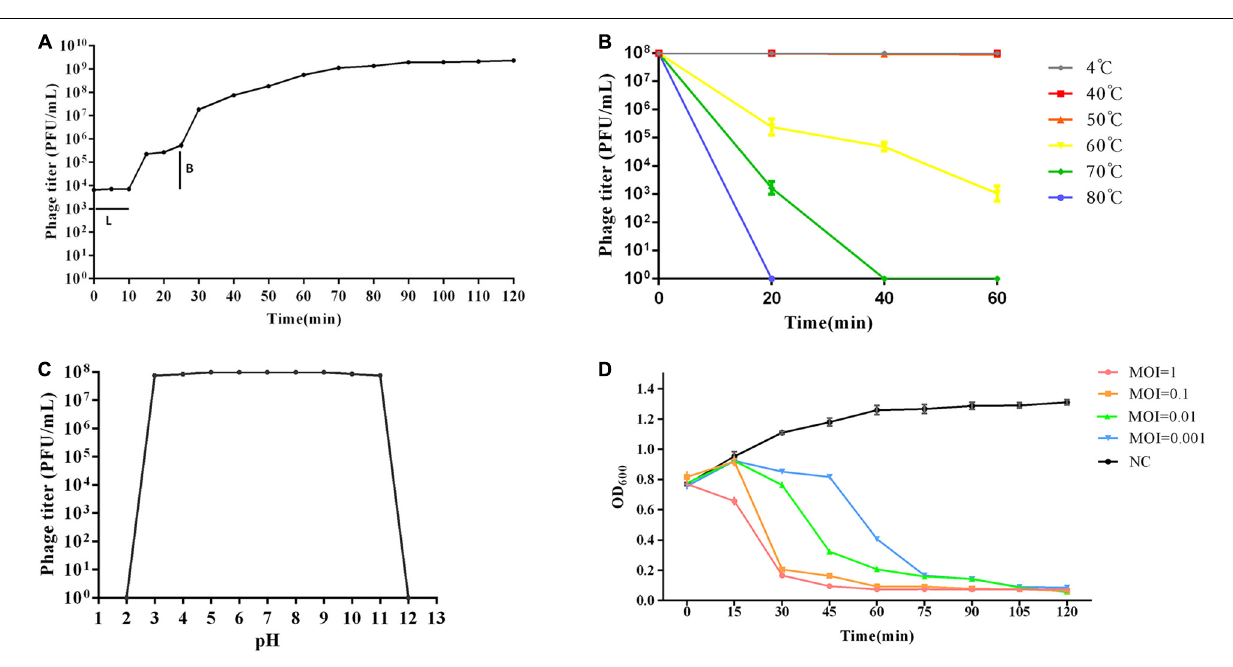
FIGURE 2 | Biological characteristics of phage vB_Kox_ZX8. (A) One-step growth curve of phage vB_Kox_ZX8. L: latency period; B: burst size; (B) Thermal stability of phage vB_Kox_ZX8; (C) pH stability of phage vB_Kox_ZX8; (D) Killing dynamic of phage vB_Kox_ZX8 against K. oxytoca AD3. Viable cell count ( OD 600 ) of cultures infected with vB_Kox_ZX8 at MOI of 1, 0.1, 0.01, and 0.001, and the uninfected control (NC) are